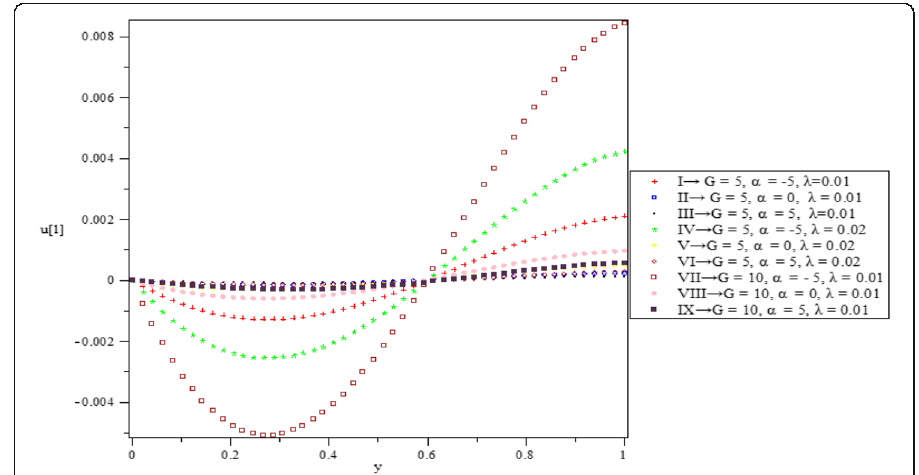
Fig. 13 First-order velocity (u[1] profile, r = − 1, ϵ = 0.25, P = 0.71, and β = 1.5)